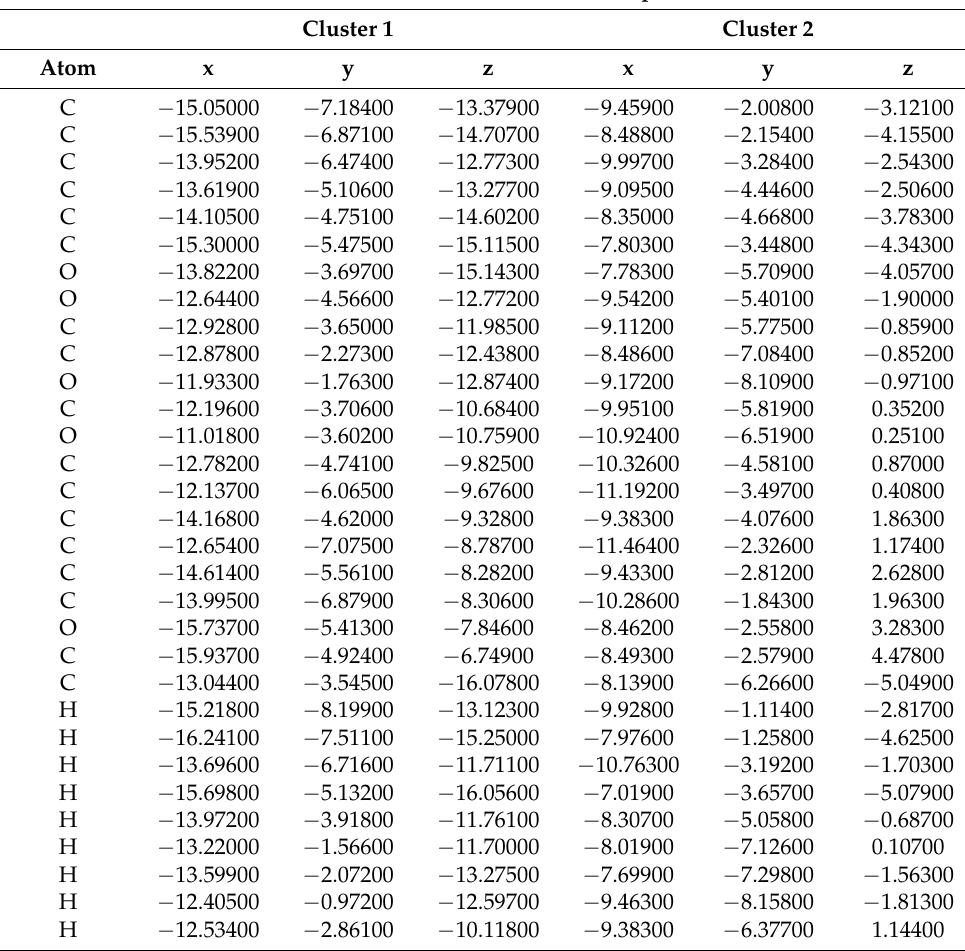
Table A1. Atomic coordinates of the system consisting of α R, β R guiacyl β -O-4, and caffeine: cluster 1 and cluster 2 structures.